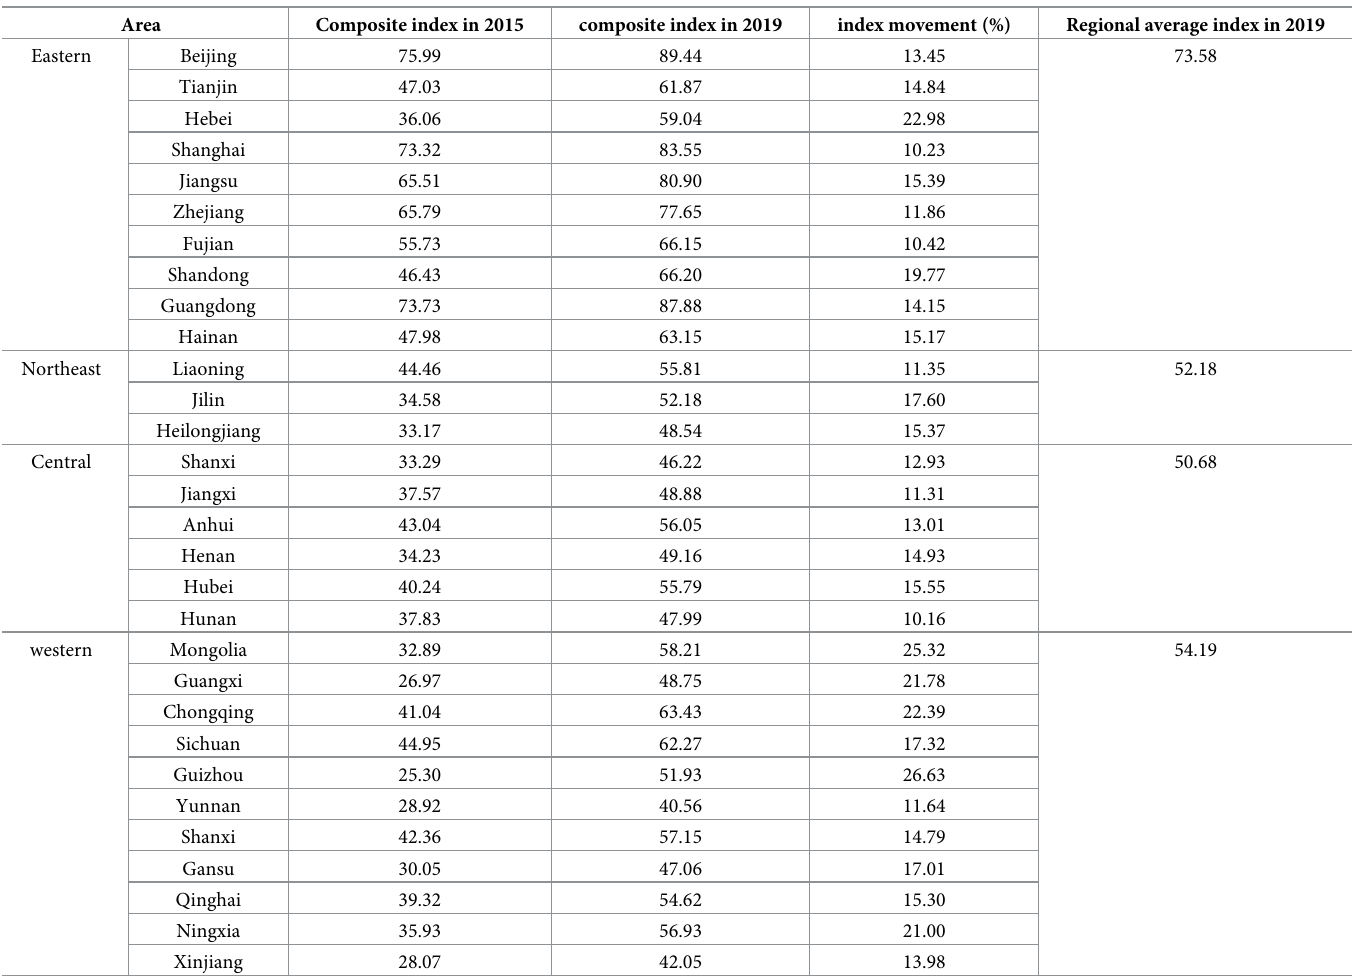
Table 2. Comprehensive index of the interprovincial digital economy in